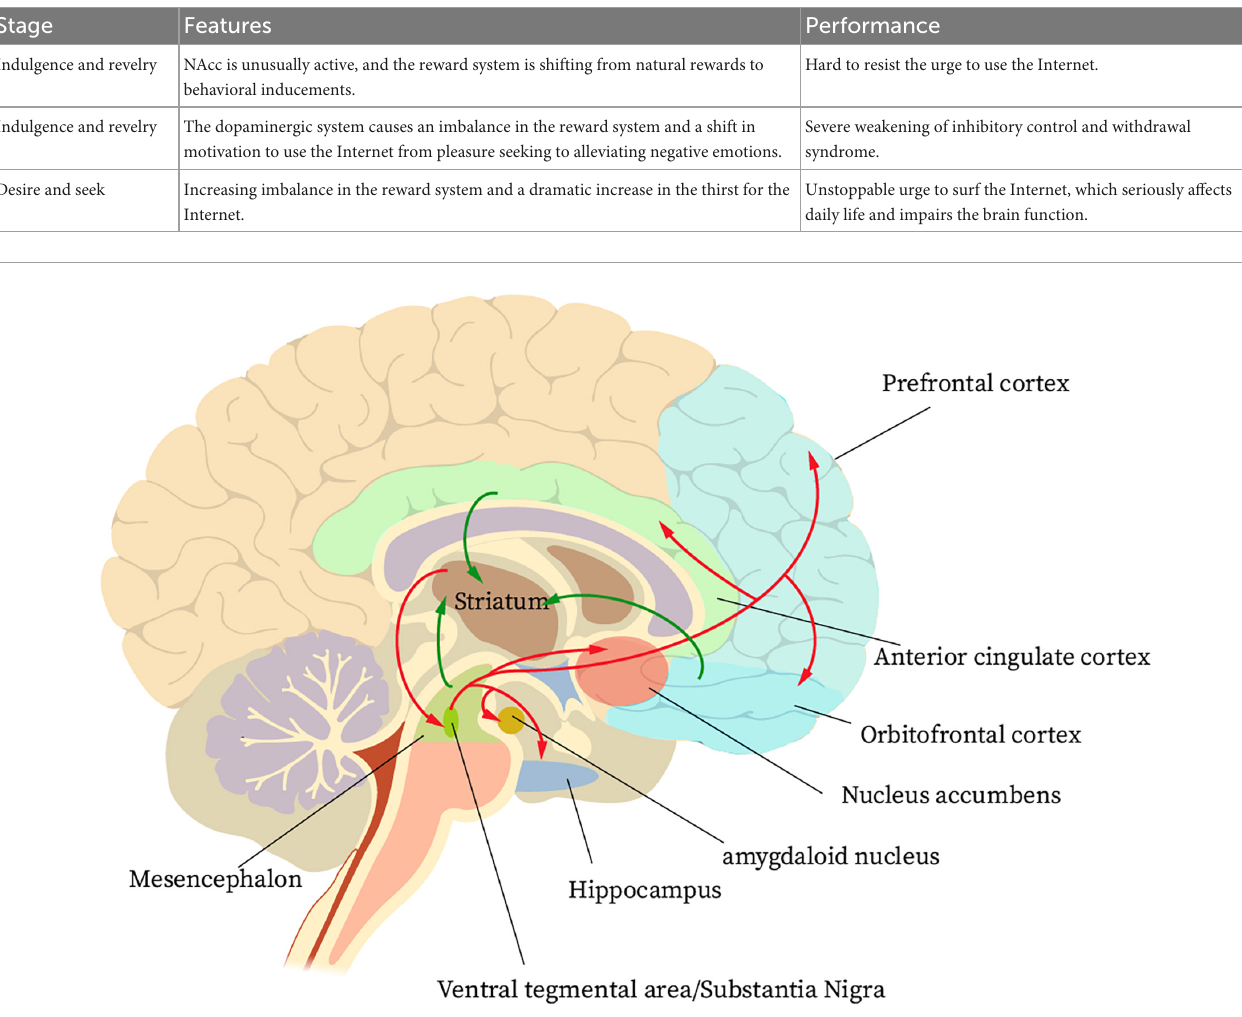
FIGURE1 The basic neural circuit of reward for internet